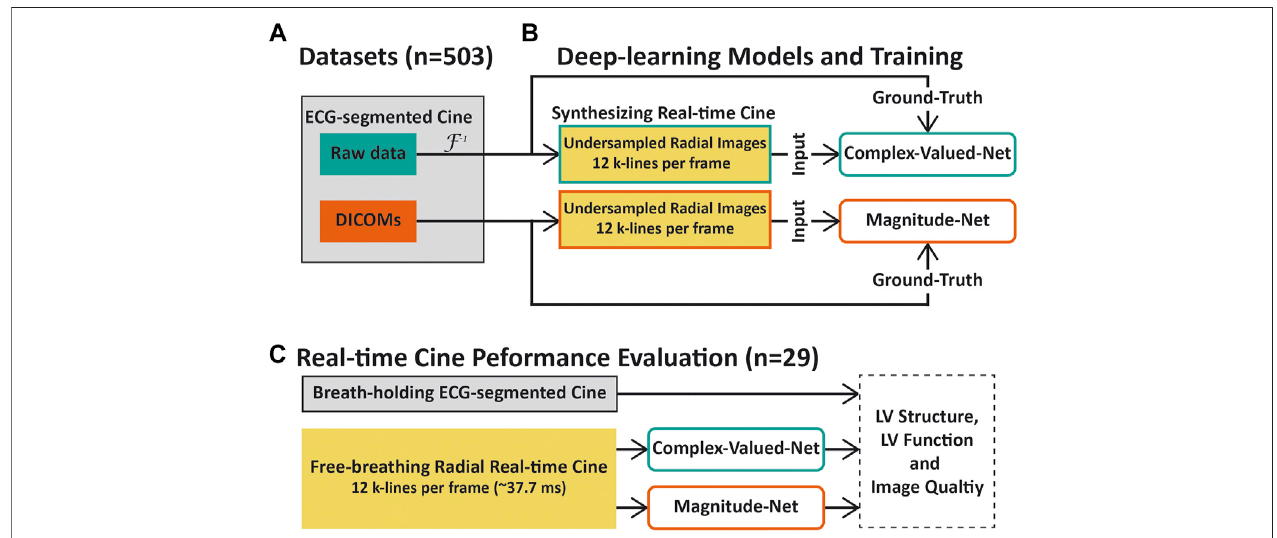
FIGURE 1 | Overview of this study. (A) Cine images of 503 patients with both raw k -space data and DICOMs were collected. These images were scanned using a breath-holding cinesequence withaCartesian trajectory. (B) Raw k -space dataand DICOMs ofECG-segmentedcinewereused tosynthesize highly accelerated radial real-time cine datasets for training Complex-Valued-Net and Magnitude-Net, respectively. (C) Performance comparison between the two neural networks. Real-time radial cine and corresponding ECG-segmented cine images were collected from 29 patients. The left-ventricular function, structural parameters, and subjective image scores were used to compare the performance of both deep learning models with respect to aliasing artifact suppression. For quantitative and qualitative evaluation, Magnitude-Net reconstruction, Complex-Valued-Net reconstruction, and ECG-segmented cine were compared to one another in pairs.